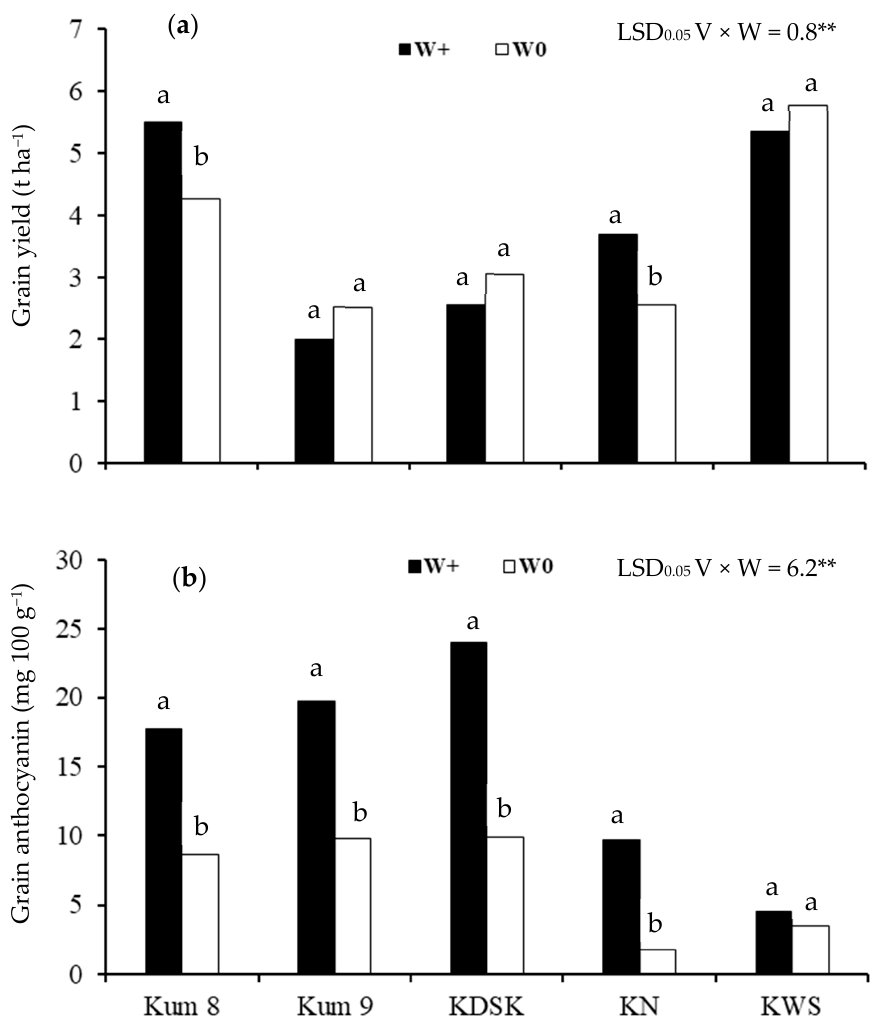
Figure 1. Grain yield ( a ) and grain anthocyanin concentration ( b ) of 5 purple rice varieties grown under 2 water regimes (waterlogged, W+; aerobic, W0) (Significant interaction effect of variety × water regime at p < 0.01 **). Different lowercase letters above the bars indicate least significant differences between water condition in each variety at p < 0.05.